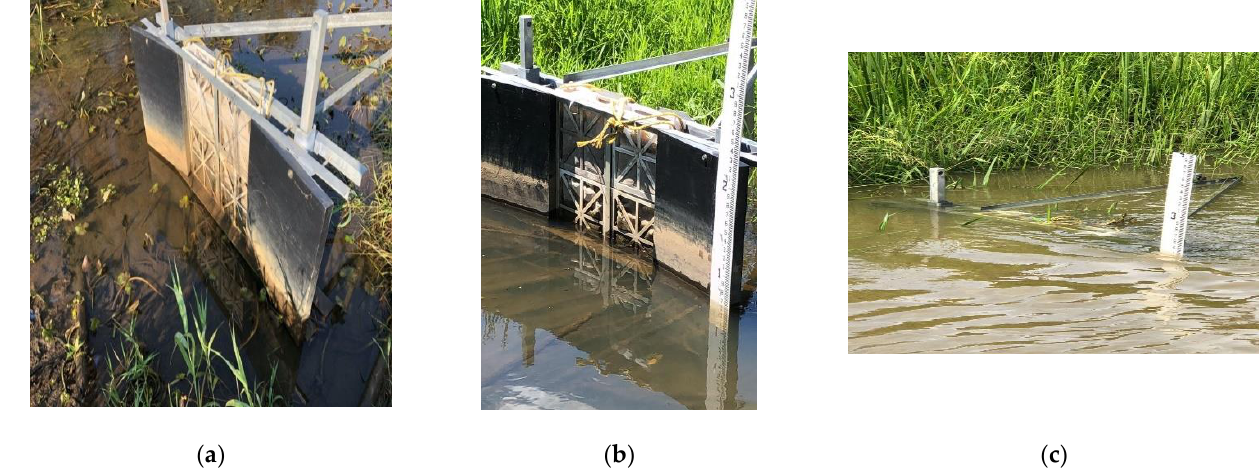
Figure 3. ( a ) Gate 2 completely above water level on 6 October 2020, ( b ) Gate 5 with measuring pole on 28 July 2020 and ( c) Gate 5 completely submerged on 8 September 2020.